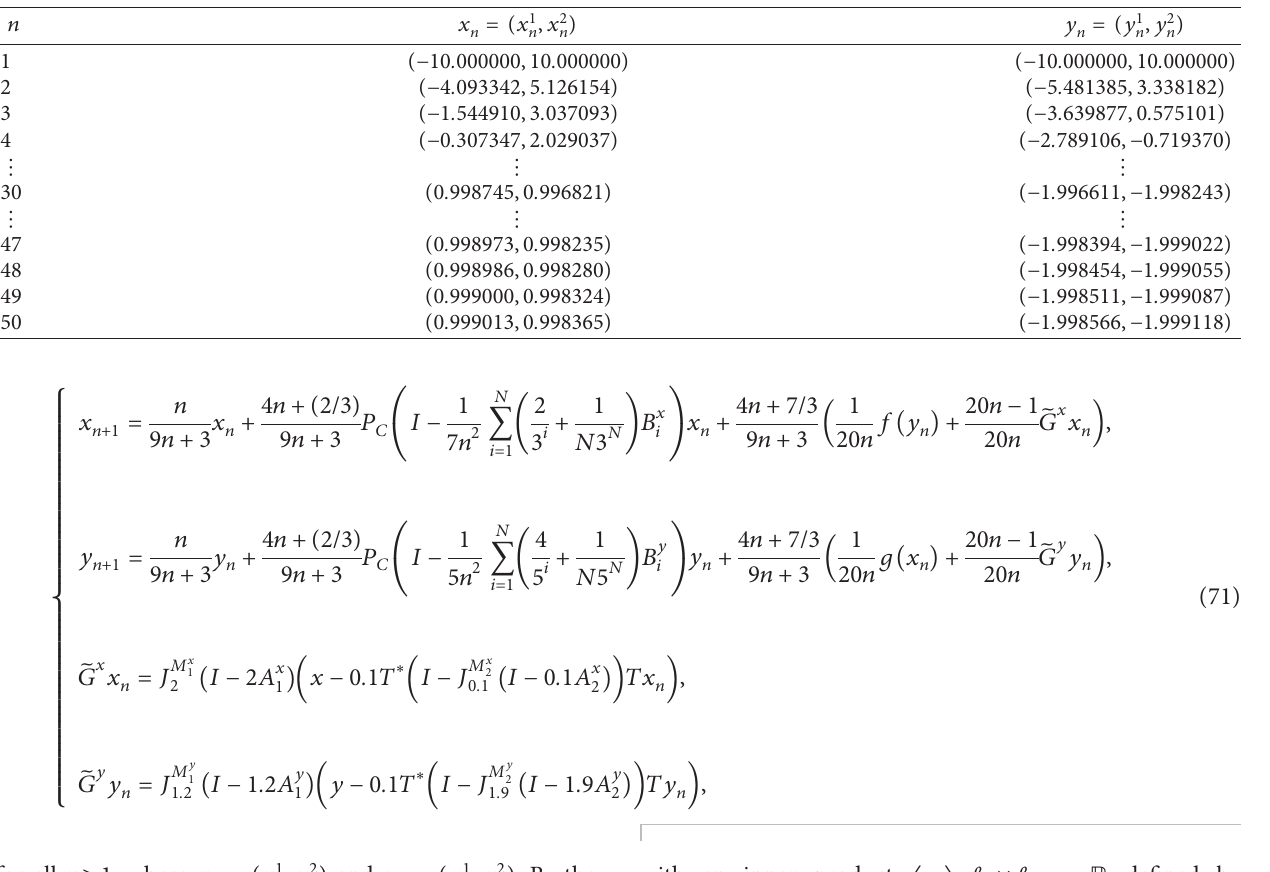
� (− 10 , 10 ) , and n � N � 1